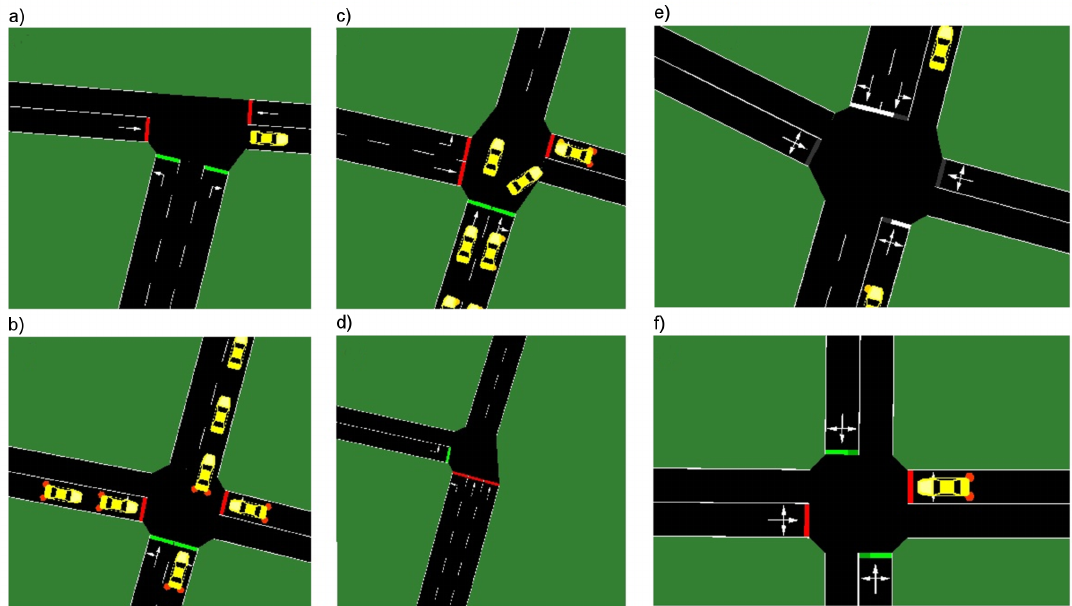
Figure 9. Intersections characteristic for: the first scenario ( a – d ); and the second scenario ( e , f